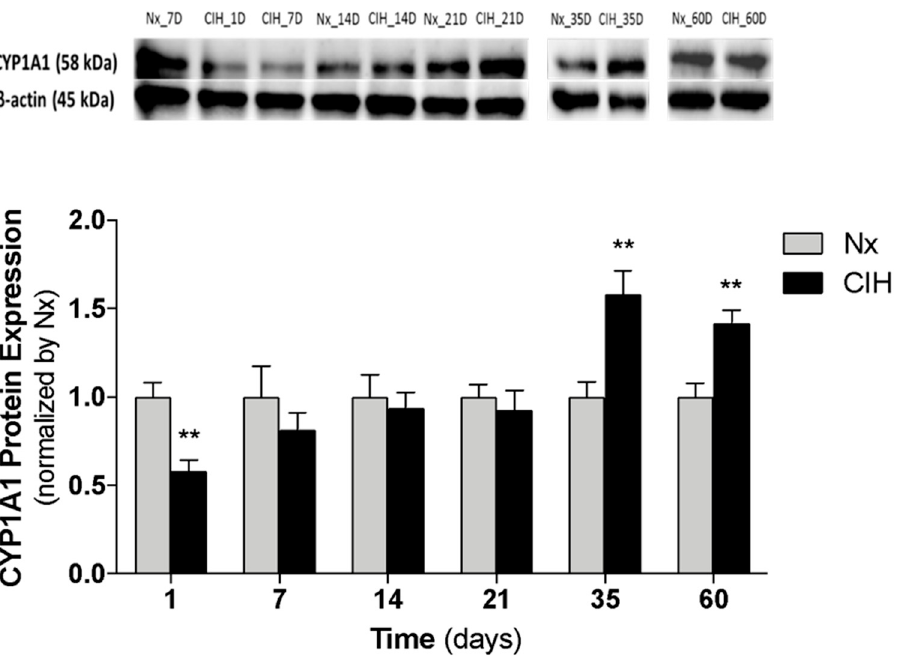
Figure 3. Impact of chronicity of IH in CYP1A1 protein expression at kidney cortex. CYP1A1 protein levels were quantified in the renal cortex of rats exposed to 1, 7, 14, 21, 35 and 60 days of CIH and Nx (controls); n = 5 animals per group. Nx7D was used as control for CIH1D and CIH7D. Multiple t-test; comparison Nx vs. CIH: ** p < 0.01. CIH: chronic intermittent hypoxia; CYP1A1: cytochrome P450 family 1, subfamily A, polypeptide 1; Nx: normoxia. Additionally, the observed increase in CYP1A1 protein levels induced by long-term CIH exposure (35 days) was reverted by the administration of the AhR antagonist CH- 223191 (Figure 4).